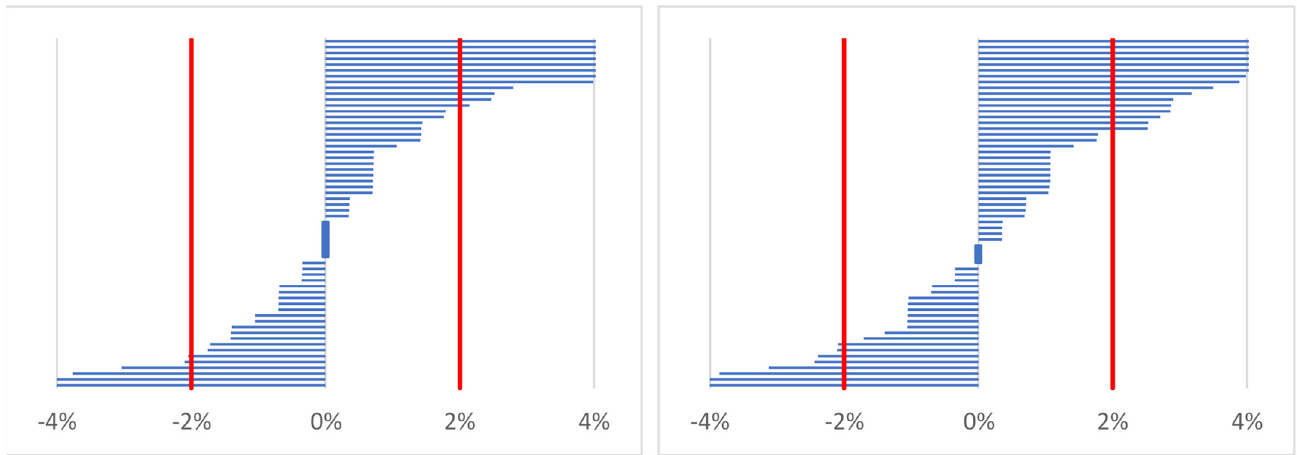
Figure 3. Distribution of changes in serum osmolality for time point 2 (after work; on the left) and time point 3 (before work on the following day; on the right) vs. time point 1 (before work/baseline) in all participants ( n = 60).